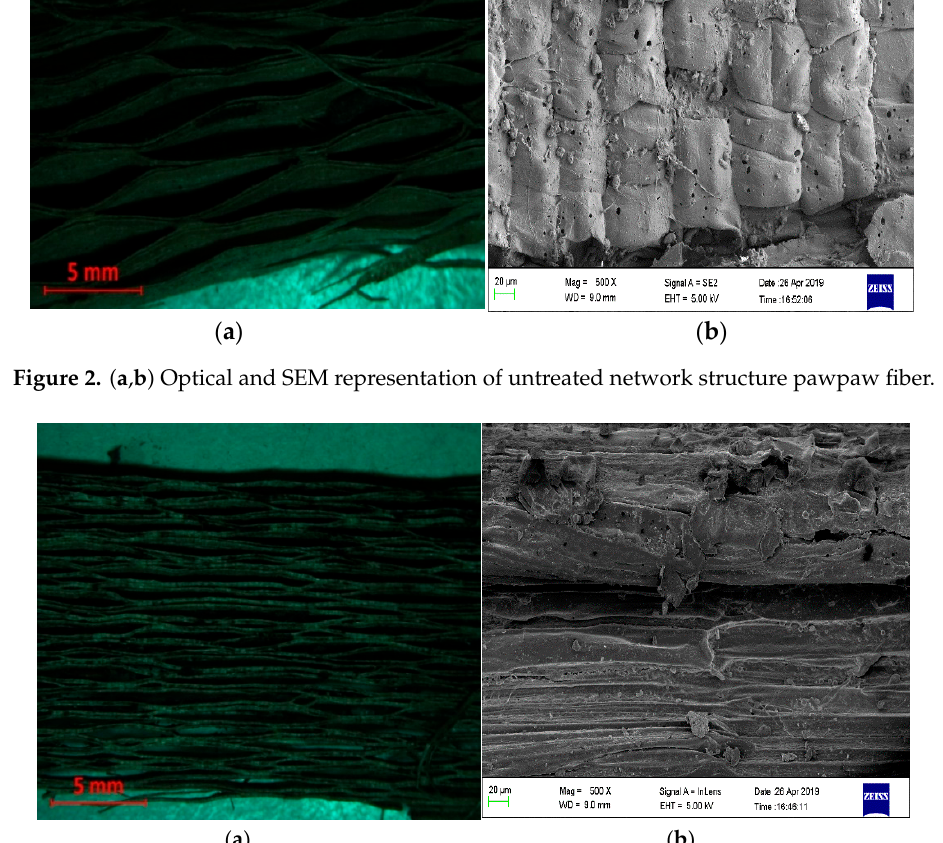
( a ) ( b ) Figure 4. ( a , b ) Optical and SEM representation of treated network structure pawpaw fiber.